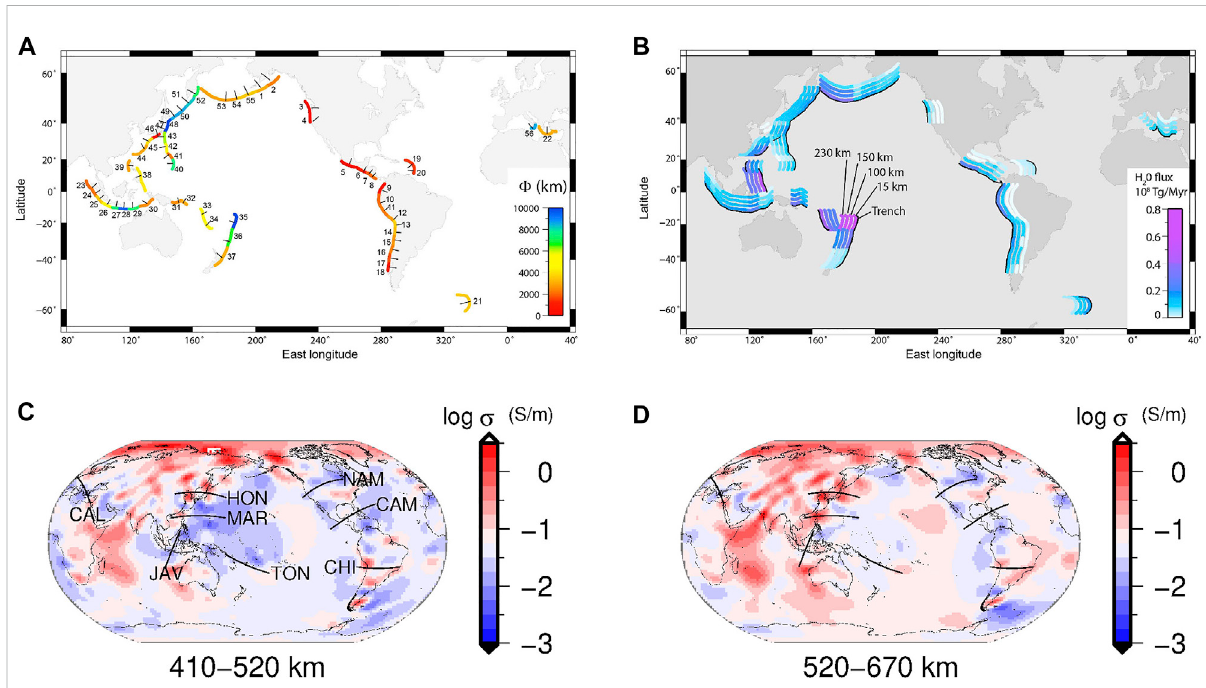
FIGURE 6 OtherresultsrelatedtothewatercontentsintheMTZ. (A) Thermalparameter Φ (theproductofconvergencespeedandageofsubductedslabs) ofsubducted slabs (Figure 1invan Kekenetal.,2011).Ahigher thermalparameter indicatesacolderslab. (B) Predicted H 2 O fl uxatselected depthsin theglobalsubductionzones.Theblacklineisthepositionoftrench.TheparallellinesshowH